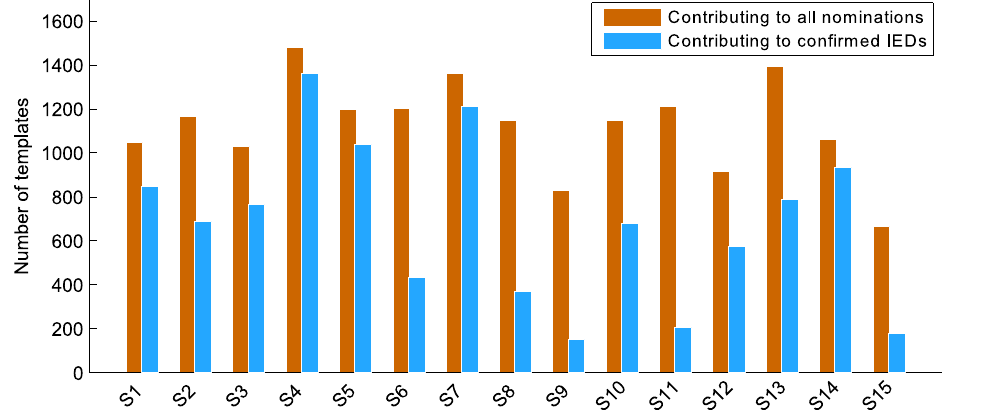
Figure 5. Template contributions per recording: The first bar shows the number of templates that have contributed to all the nominations presented during a review of fifteen iterations. The second bar shows the number of templates that contributed to confirmed IEDs only. doi:10.1371/journal.pone.0085180.g005 PLOS ONE |